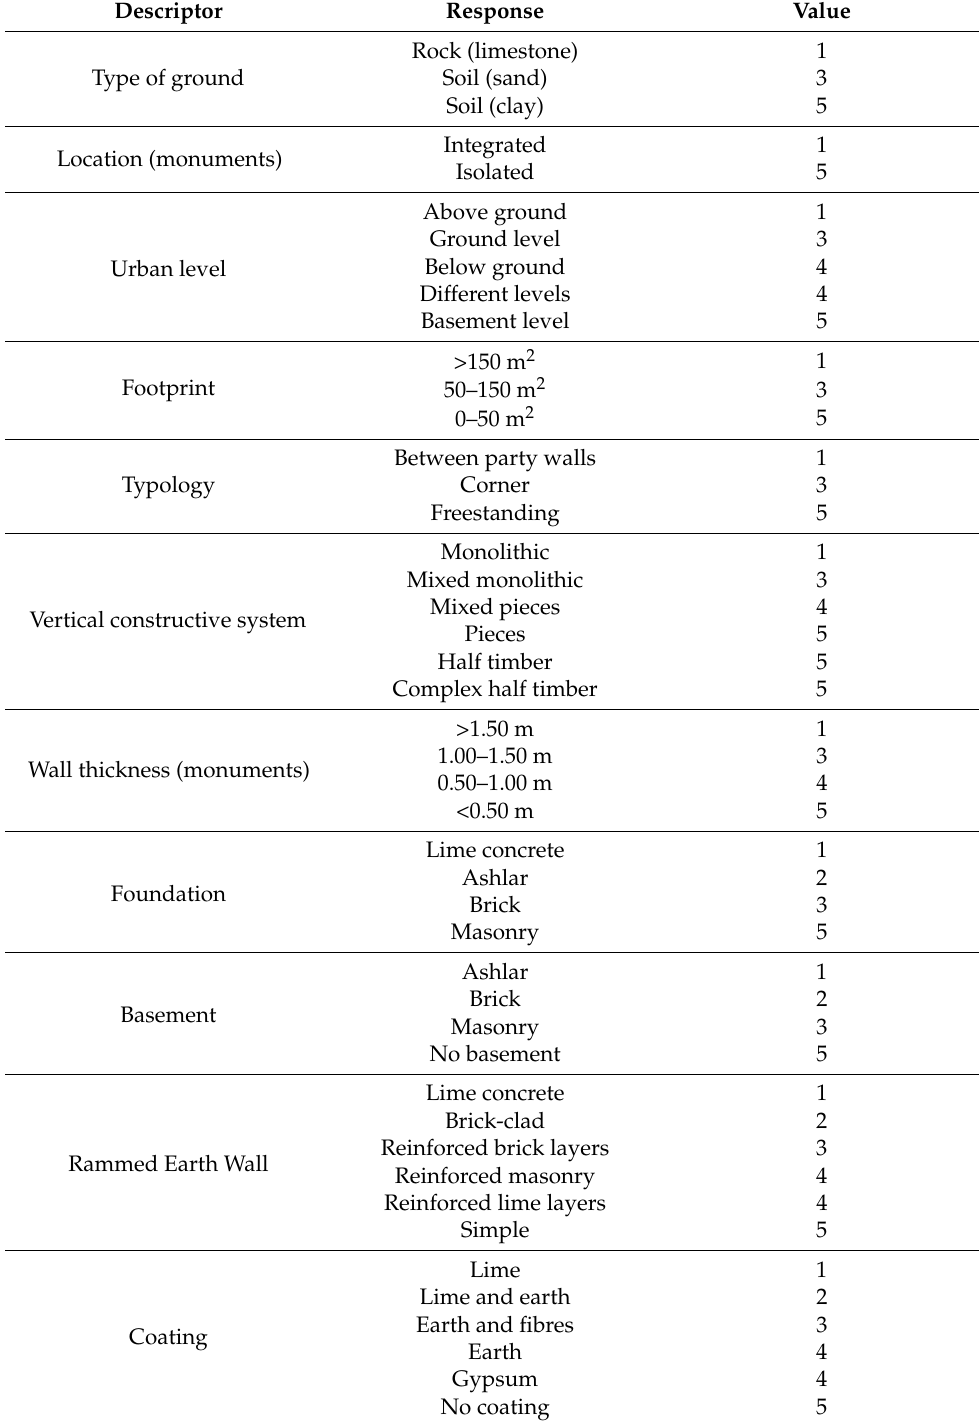
Table 3. Building vulnerability descriptor